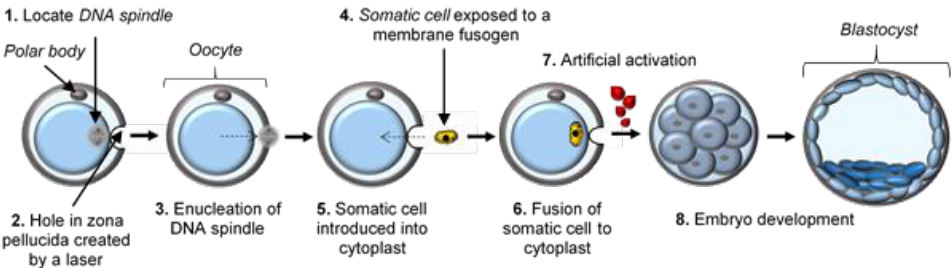
Figure 1. Schematic representation of the steps (1–8) involved in laser-assisted SCNT. Dashed arrows represent removal of the spindle in step 3, and transfer of the somatic cell into the cytoplast in step 5.